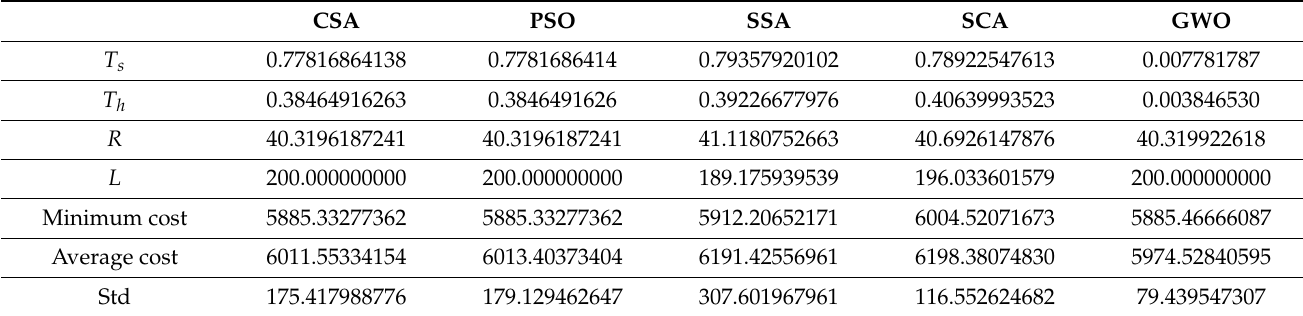
Table 13. Optimal design of pressure vessel.